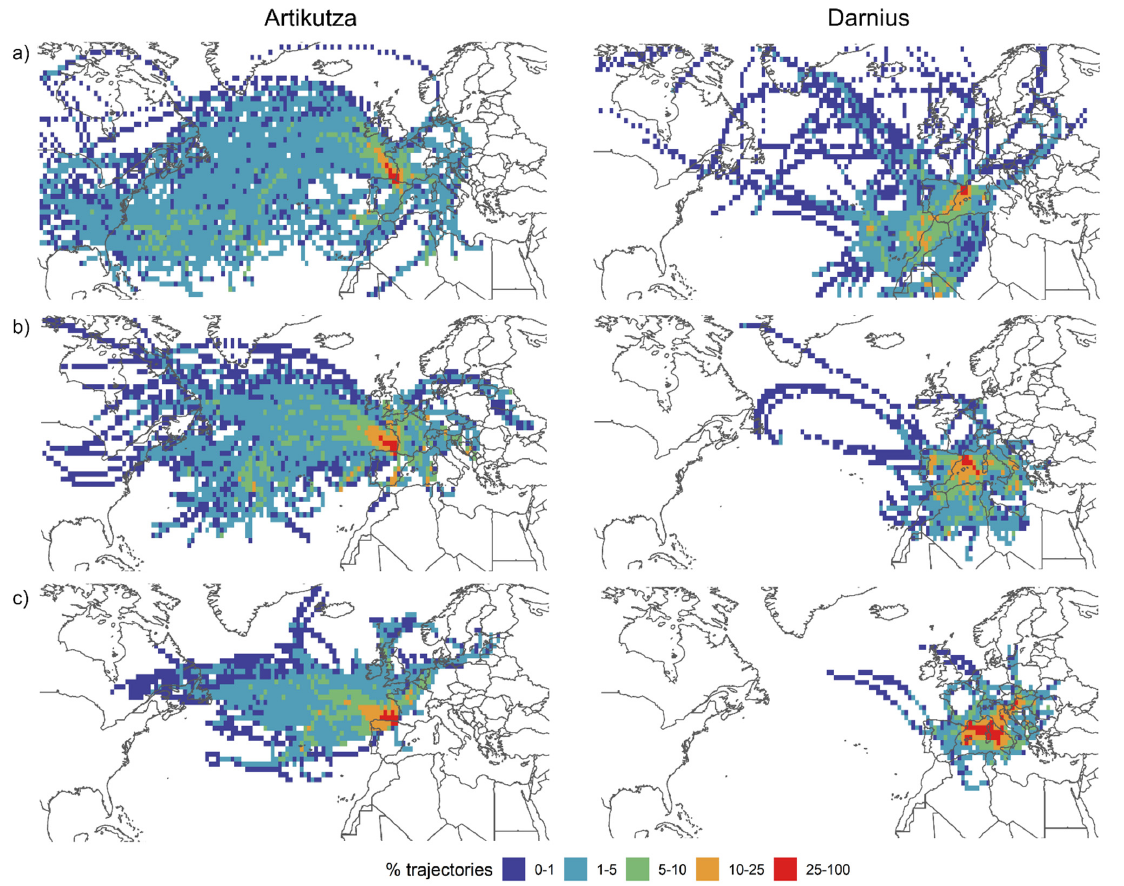
Figure 8. Backward trajectories for Artikutza (NW of the study area) and Darnius (E of the study area) for their respective days with torrential rainfall. The trajectories were computed for three different altitudinal layers: ( a ) 500 hPa, ( b ) 850 hPa and ( c ) surface.